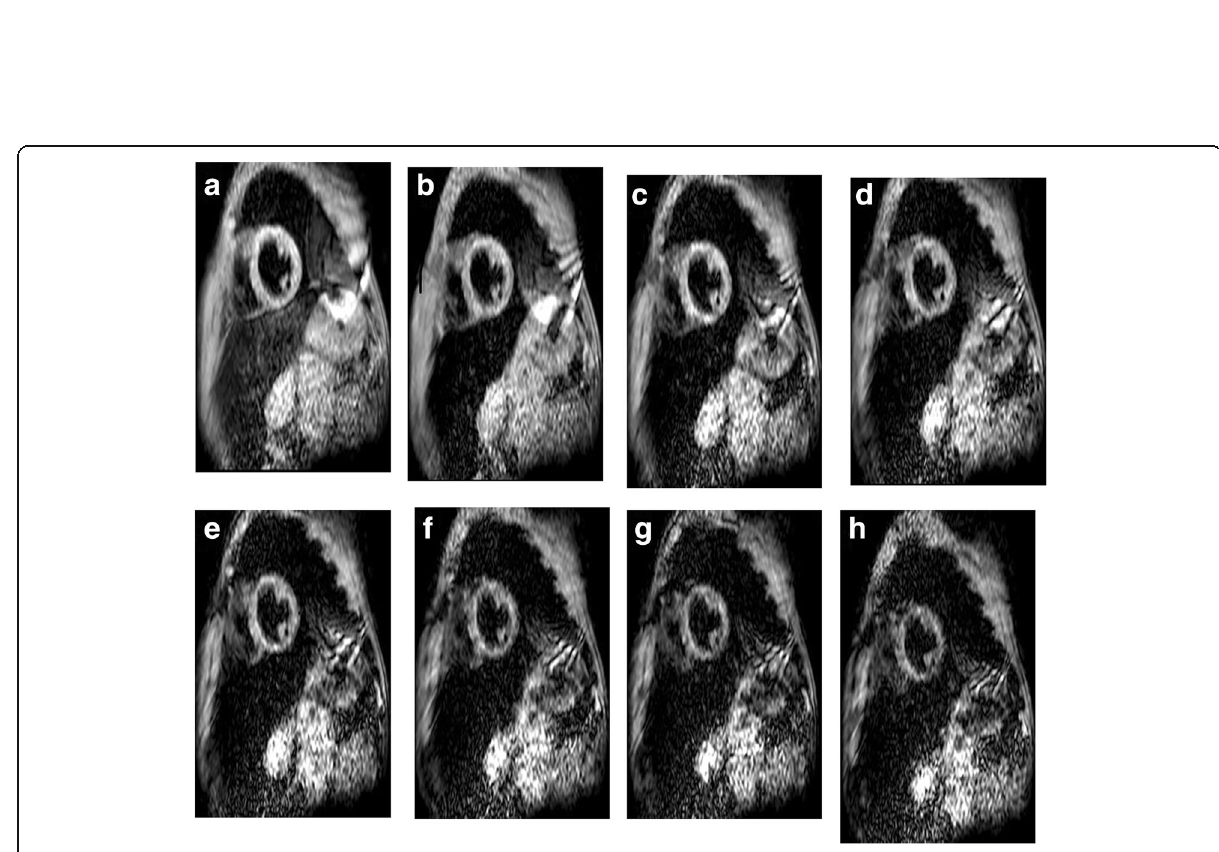
Fig. 5 Black blood static images of the liver & heart acquired at different 8 echo times (1.6-18.7ms) reveals a significant decrement in liver signals with measured values of (T2*: 1.1 ms & LIC: 28.91 mg/g) and normal heart signals with normal (T2*: 43.9 ms & MIC: 0.45 mg/g). The measured serum ferritin was 7000 ng/ml. Findings are consistent with severe hepatic iron deposition with normal cardiac